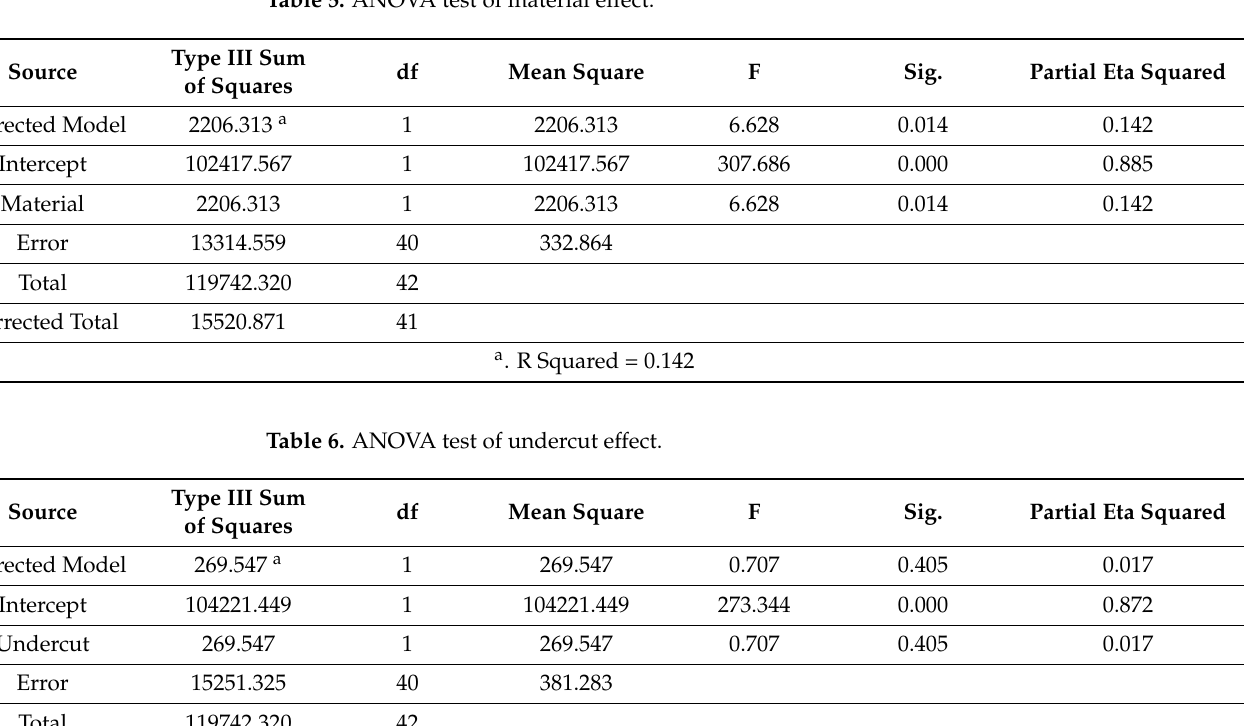
Table 5. ANOVA test of material effect.